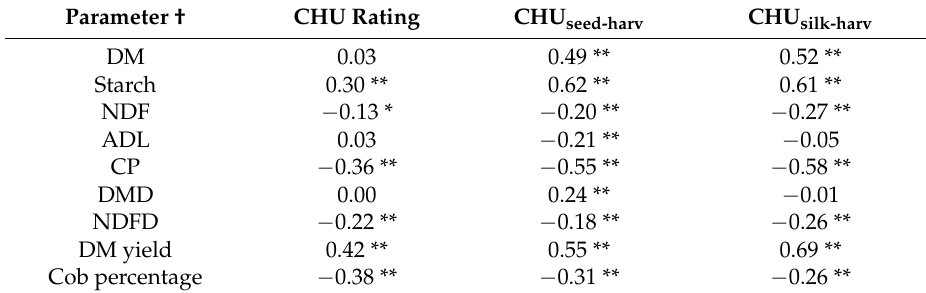
Table 9. Correlation coefficients between hybrid corn heat unit rating (CHU rating), corn heat units between seeding and harvesting (CHU seed-harv ) and between silking and harvesting (CHU silk-harv ), and nutrients (g kg − 1 ), yield (Mg ha − 1 ), and cob percentage (% DM) of whole-plant corn grown for silage over all